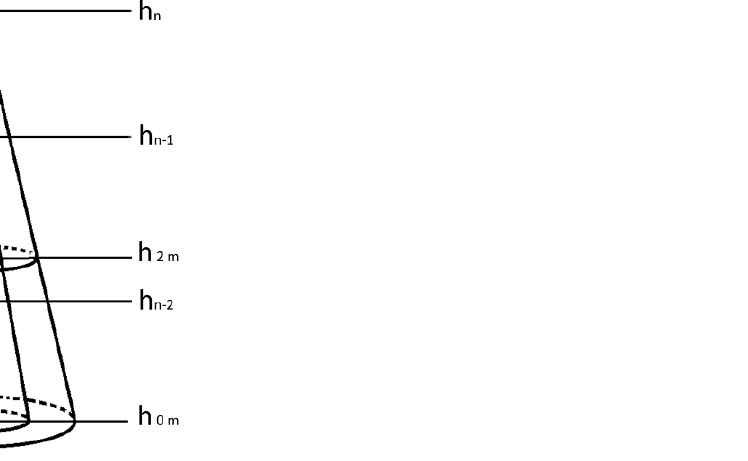
Figure 1. The biometric features used for stem volume estimation for each growing season. The field activity included felling and weighing the trees, cleaning branches and re-weighing the cleansed trunk, measuring the total length of the stem and the annual height growths, sectioning the stem to 2 m, measuring the lengths and diameters